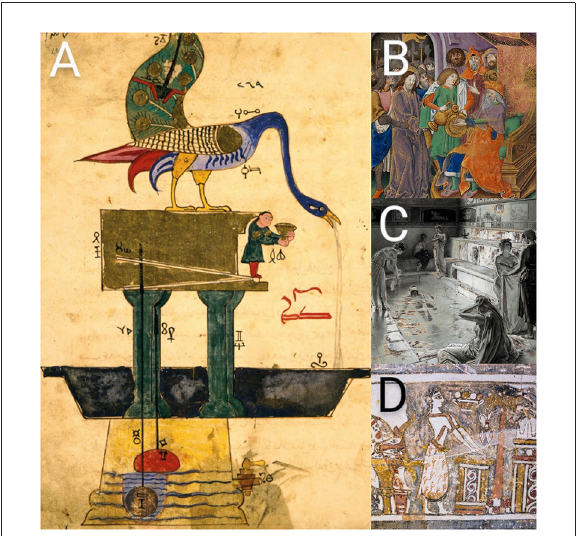
FIGURE1 (A) The Book of Knowledge of Ingenious Mechanical Devices (1206) by the Mesopotamian polymath Ibn al-Razz¯az al-Jazari (1136–1206), depicts a peacock basin automaton for ritual hand washing. We do not know with certainty that al-Jazari’s device was ever actually constructed. Photo courtesy of the Cleveland Museum of Art. (B) Handwashing was also associated with the removal of sin and misfortune. The Peniarth Manuscript ca. 1503 depicts Christ before Pilate, with Pilate washing his hands